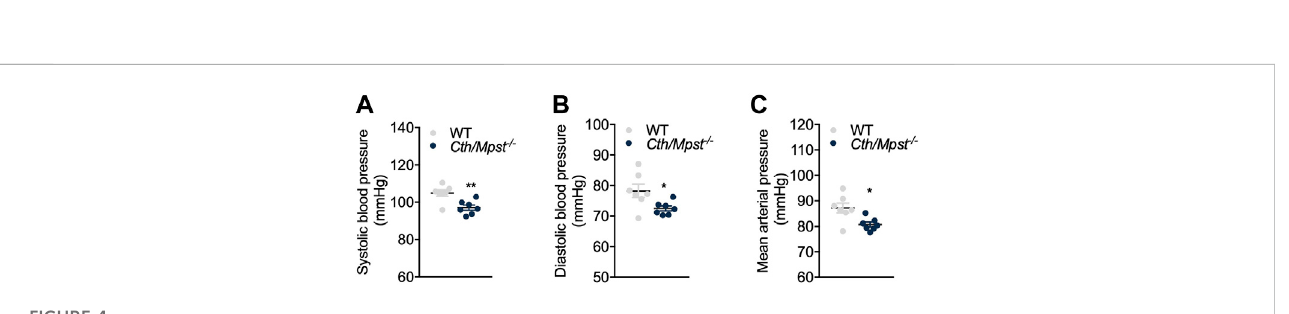
FIGURE 4 Cth/Mpst − / − mice exhibit reduced blood pressure. (A) Systolic, (B) diastolic and (C) mean arterial blood pressure of WT and Cth/Mpst − / − mice. Data are presented as means ± S.E.M, * p < 0.05 and ** p ≤ 0.01, N = 7 mice per